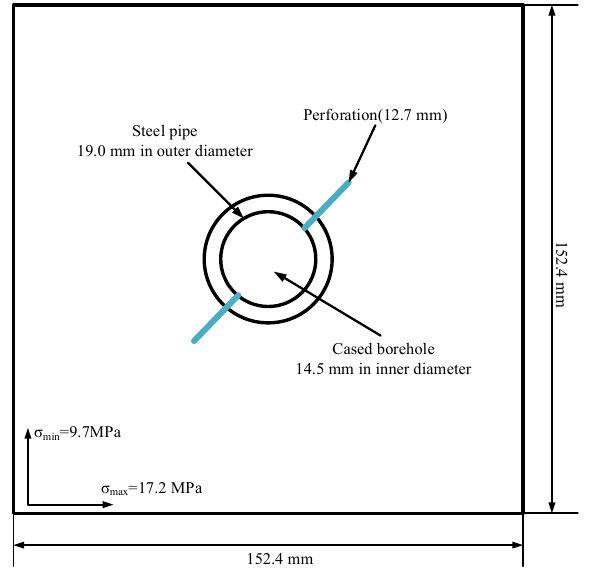
Figure 1. Model schematic diagram of validation case 1 [5]. Table 1. Mechanical properties of hydrostone samples and experimental conditions in Abass et al.’s experiment [20,23].